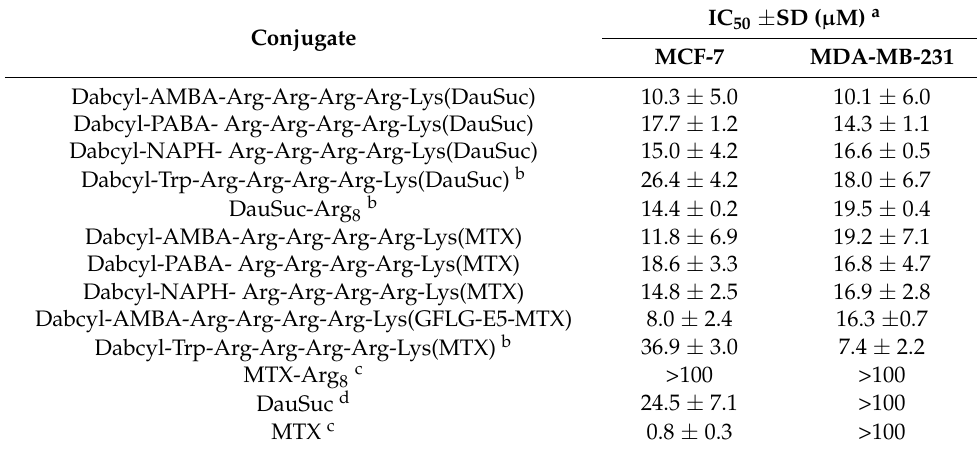
Table 3. Cytostatic activity of peptide/drug conjugates on MCF-7 and